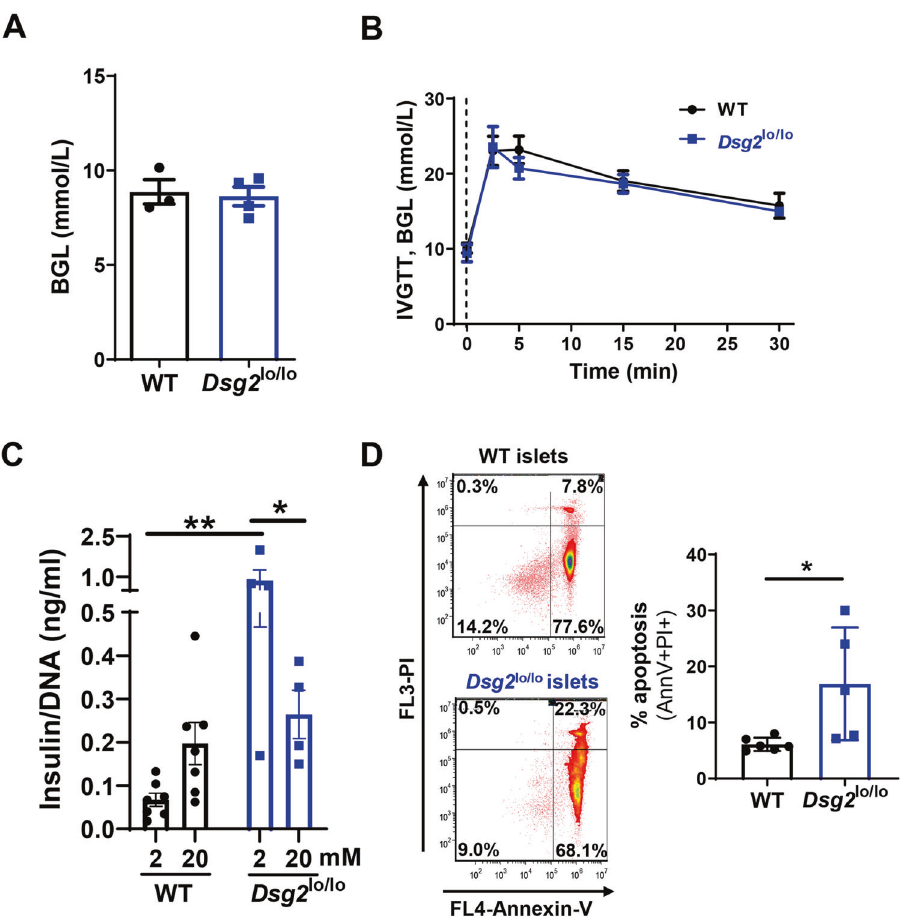
Fig. 5 Islet function in Dsg2 lo/lo and wildtype mice. A Baseline blood glucose levels (BGL) in WT and Dsg2 lo/lo mice. Results are mean ± SEM, n = 3 – 4 mice per group. B Glucose tolerance in WT and Dsg2 lo/lo mice following i.v. injection of 1 g/kg glucose with BGLs measured at 0 (dotted line), 2.5, 5, 15, and 30 min post injection. Data are expressed as mean ± SEM from n = 7 – 9 individual mice per group. C Islets isolated from WT or Dsg2 lo/lo mice tested for glucose-stimulated insulin release at low glucose (2 mM) and then high glucose (20 mM) for 1 h, represented as mean ± SEM of insulin release to DNA, n = 4 – 7 mice per group. D Cytokine induced apoptosis of islets isolated from WT and Dsg2 lo/lo mice. Islets were exposed to TNF α , IL-1 β and IFN γ for 72 h prior to staining for with Annexin V and propidium iodide (PI) to assess cell death, n = 4 – 6 mice per group and 3 separate experiments, * p < 0.05 vs